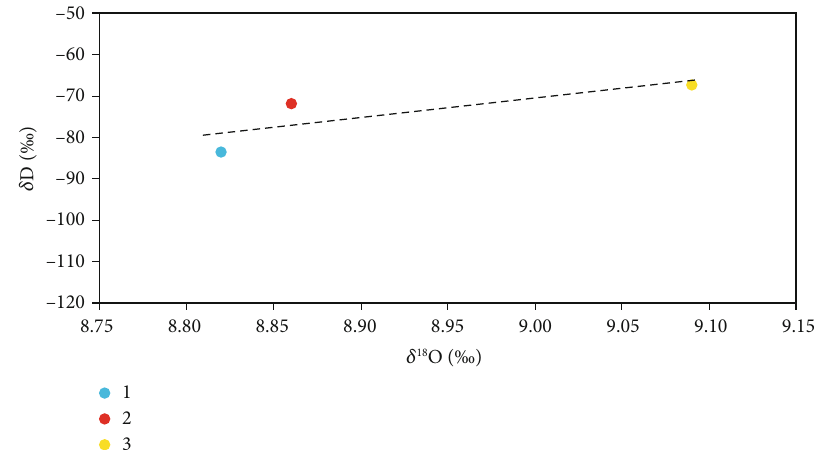
Figure 6: Correlation diagram of Laoshan granites δ 18 O- δ D: 1: Laojun cave sample; 2: Ciguang cave sample; 3: bedrock